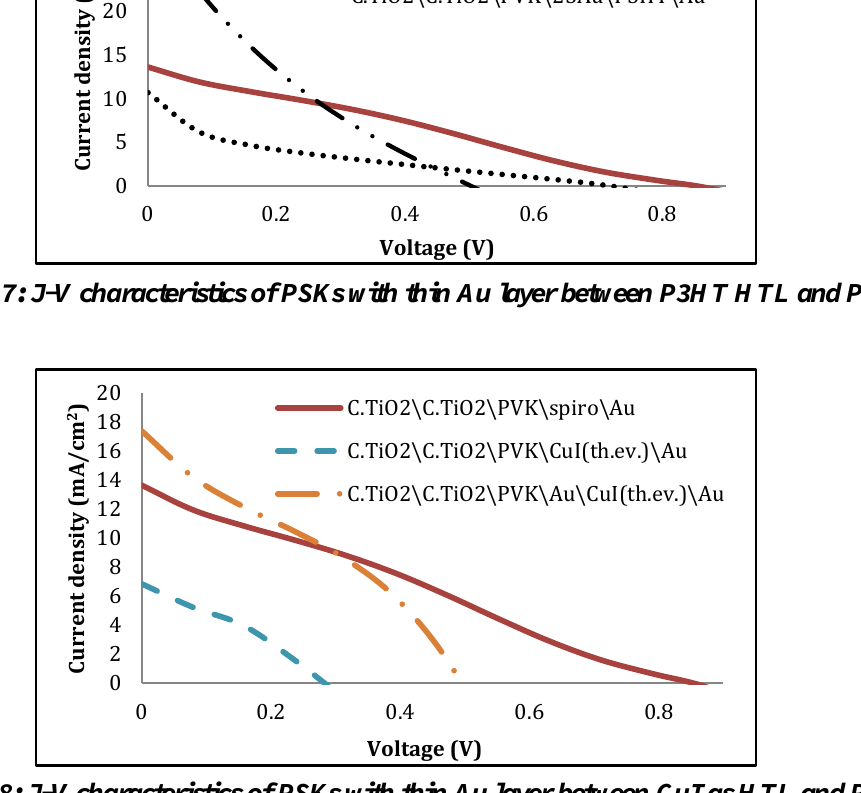
Figure 8: J-V characteristics of PSKs with thin Au layer between CuI as HTL and